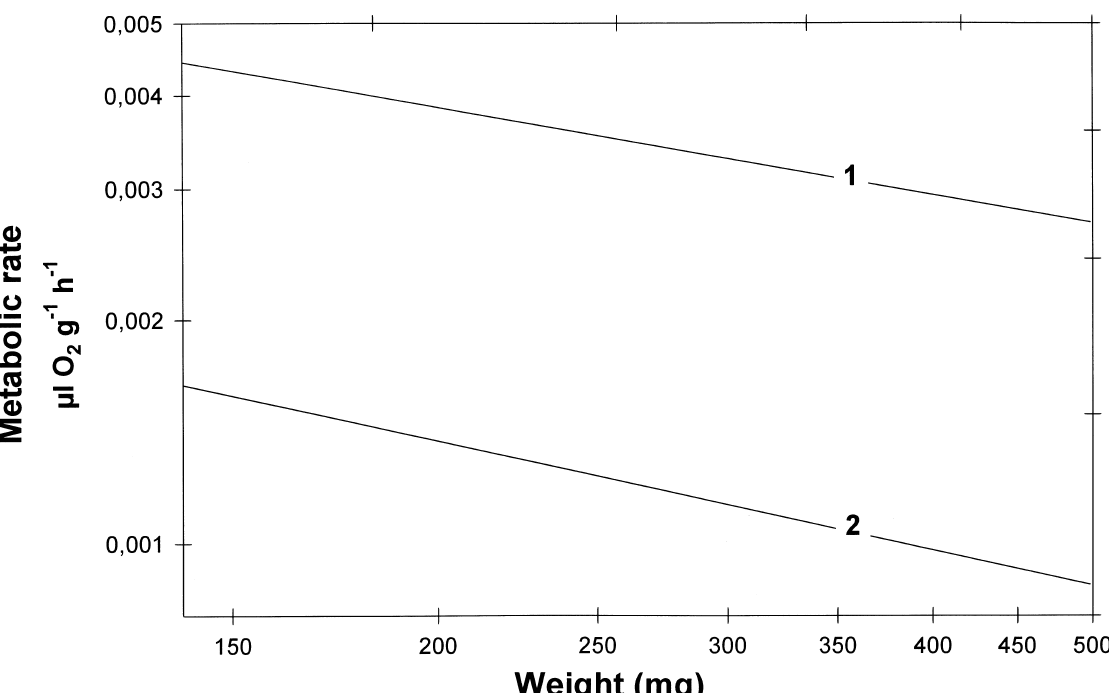
Fig. 2. Regression lines standing for the relationship of Log metabolic rate on Log live mass in specimens G. balcanica fed on non- contaminated (1) and contaminated food (2). Regression coefficients b are –0.39 ± 0.06 and –0.49 ± 0.04 for animals fed on non- contaminated and contaminated food respectively.